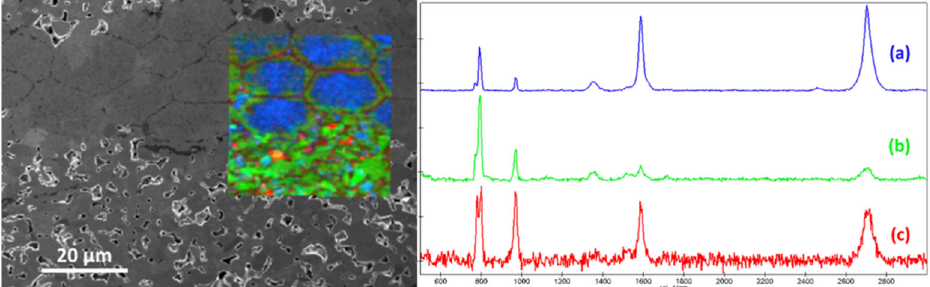
Figure 6. Position distribution of the Raman spectrum of the SiC f /SiC specimen: left RISE image; right Raman spectrum: where ( a ) is fiber, ( b ) is matrix, and ( c ) is porosity.